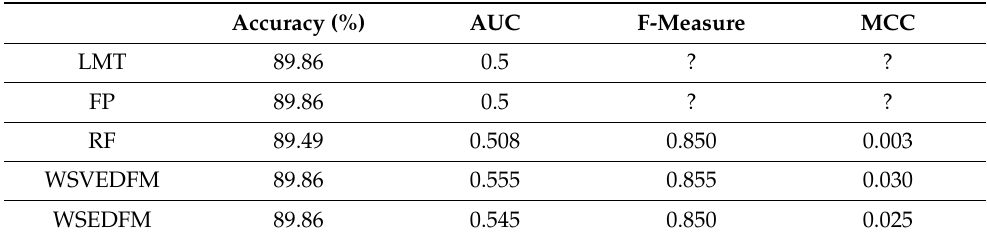
Table 8. The CCP performance of DF models and their Enhanced ensemble variants on original Dataset 2.